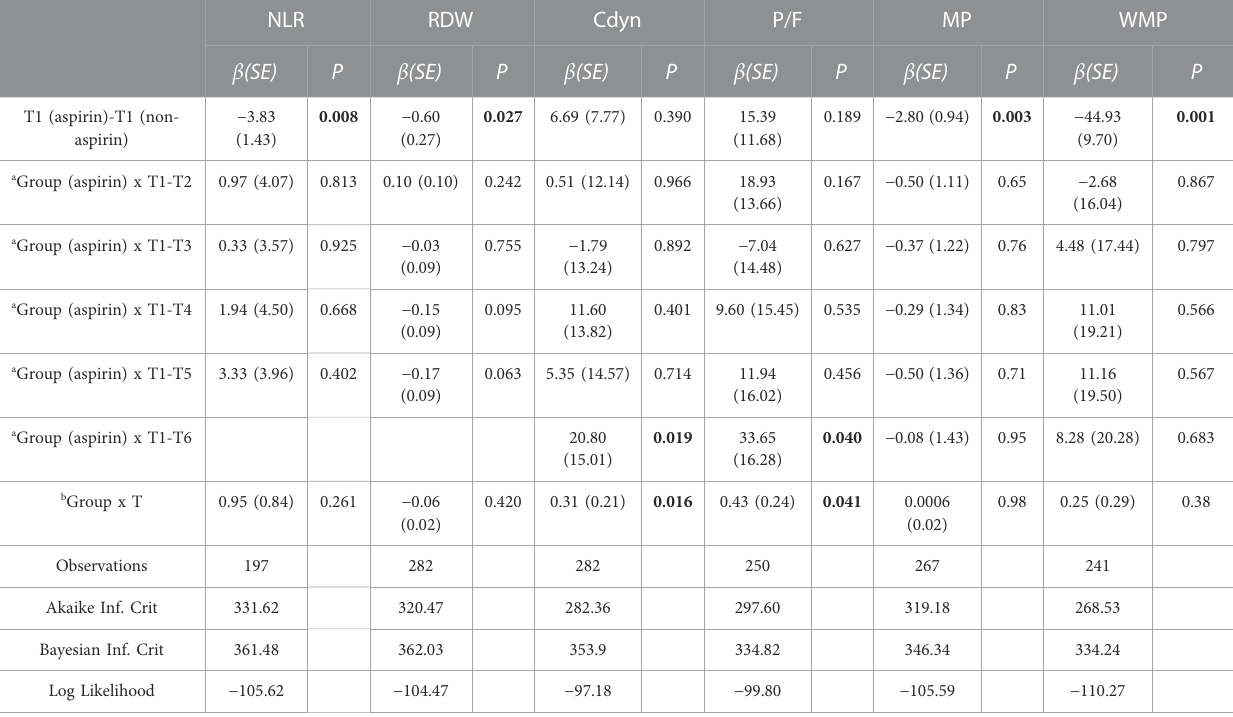
TABLE 2 Longitudinal red cell distribution width, neutrophil to lymphocyte ratio, PaO 2 /FiO 2 , dynamic lung compliance, mechanical power, and mechanical power normalized to predicted body weight derived from a linear mixed-effects regression